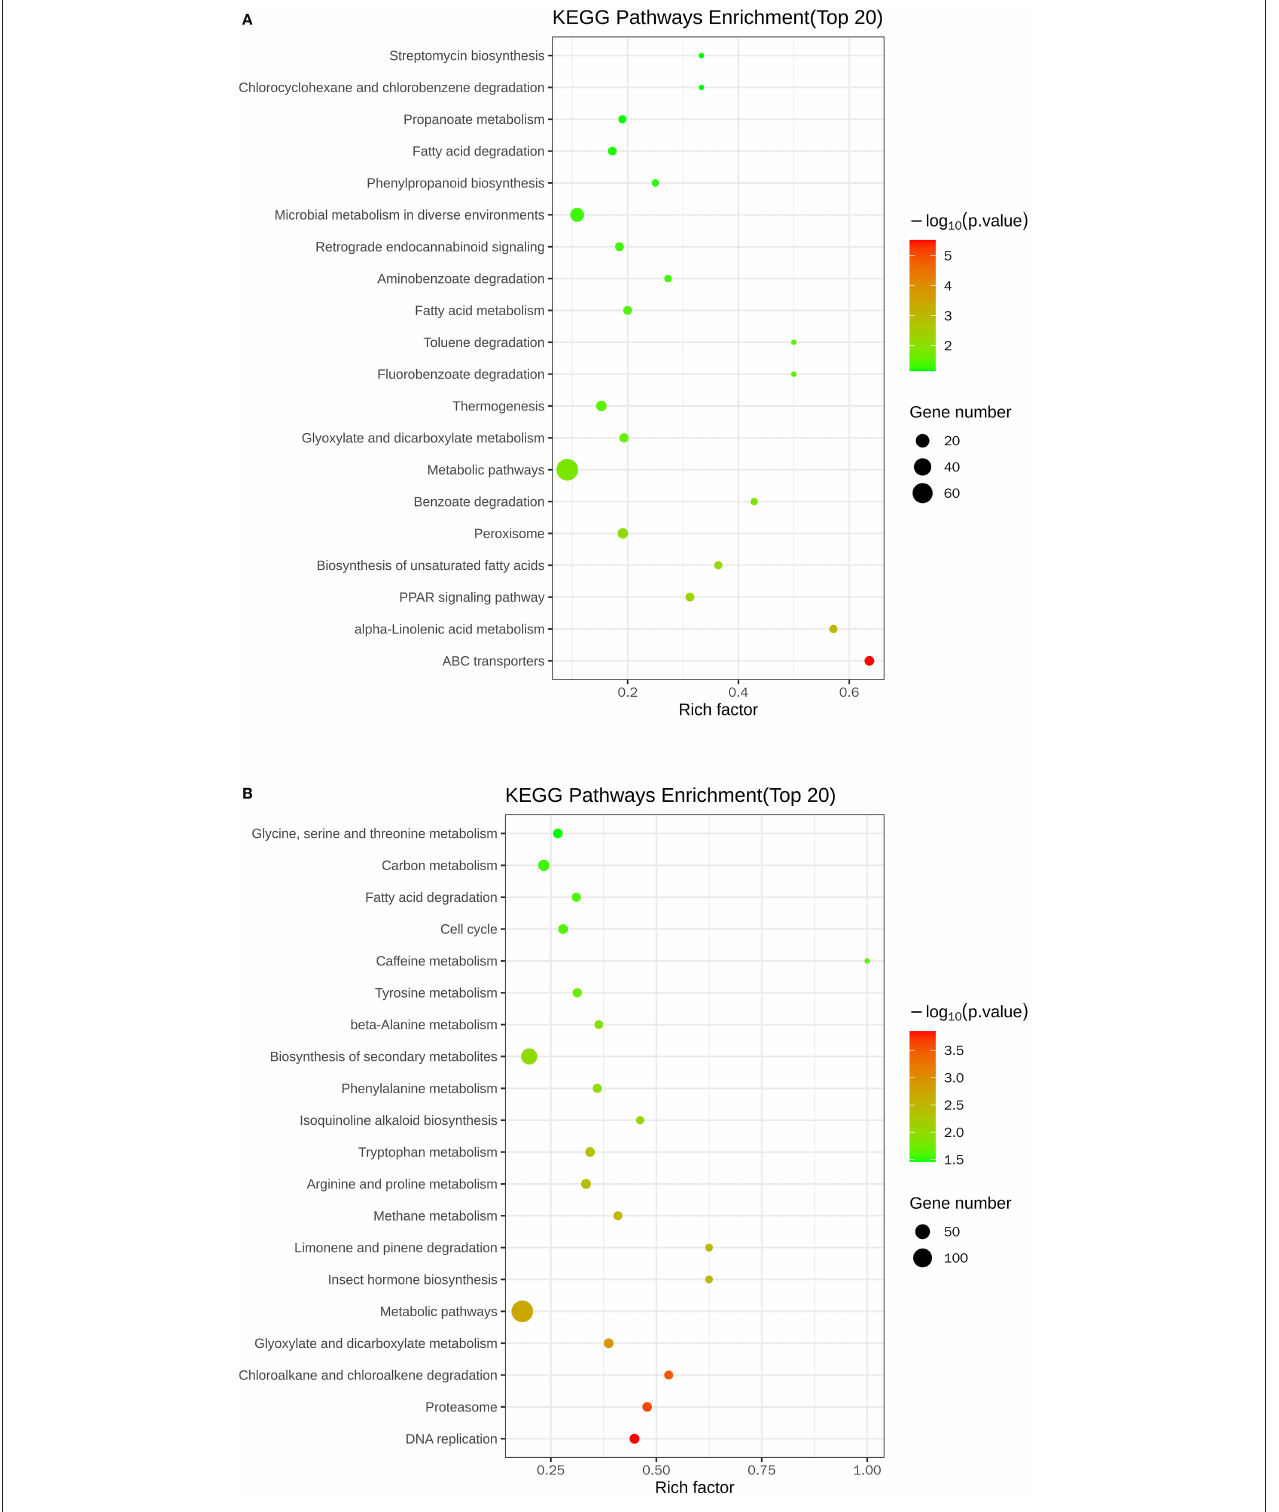
FIGURE 6 | Scatter plots of the top 20 KEGG enrichment of upregulated (A) and downregulated (B) DEGs between control and nanoemulsion treatment.